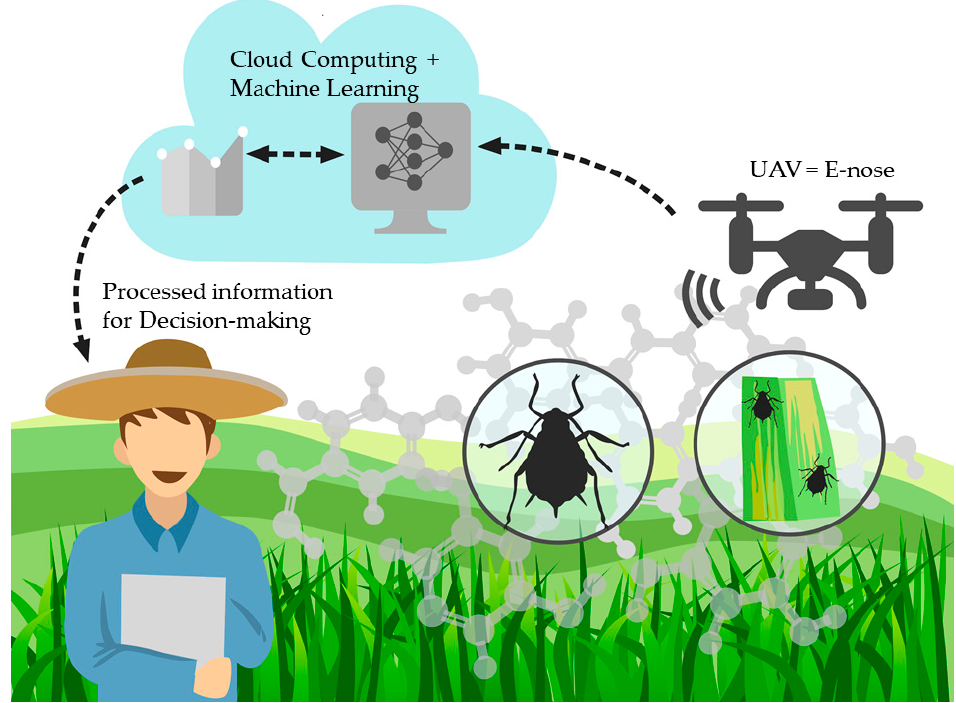
Figure 10. Diagram showing the proposed validation and deployment of machine learning models developed for early detection of aphids in wheat fields using an unmanned aerial vehicle and the e-nose as payload.